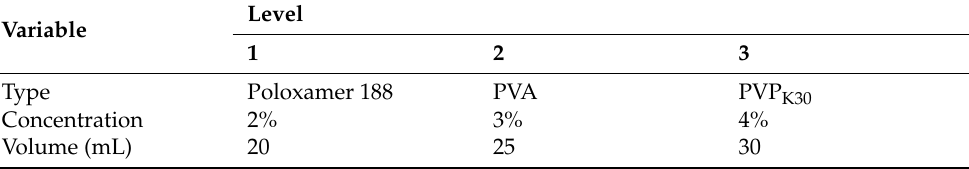
Table 1. Factor level table.